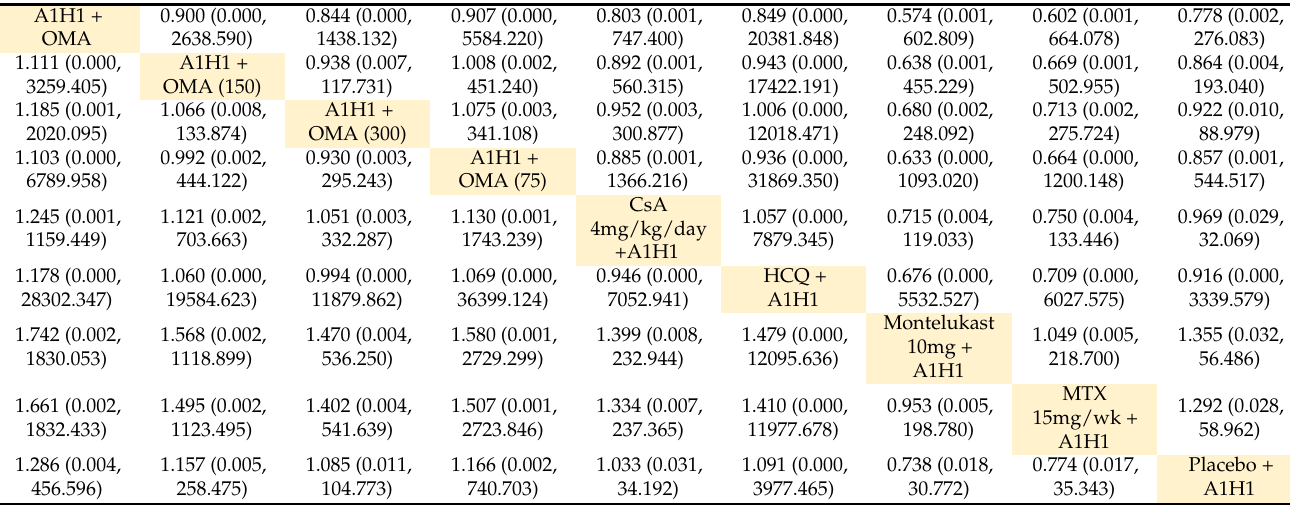
Data are expressed as the odds ratio (95% confidence interval) for adverse effects. Comparisons of the lower left triangle should be read from left to right, but comparisons between treatments in the upper right triangle should be read from right to left. In the upper triangle, a value of >1 indicates that the treatment in the corresponding row tends to produce related adverse events. A1H1, H1-antihistamine; CsA, cyclosporin; HCQ,